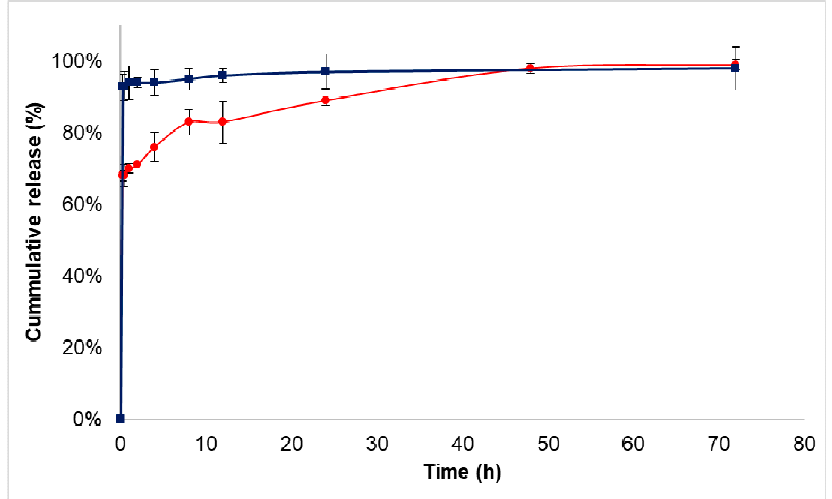
Figure 5. Cumulative drug release of sorafenib from dual drug-loaded 12CL nanoparticles in sodium acetate buffer at pH 5.5 (red) and in blood plasma at pH 7.4 (blue).